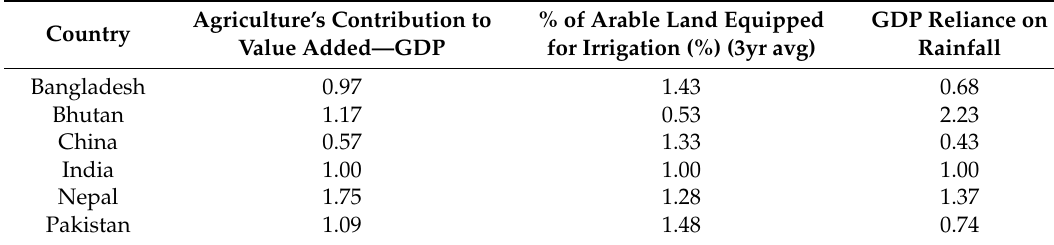
Table A2. National factors for reliance of GDP on rainfall for 2003 [24,25] calculated from the proportion of each country’s provided by the agricultural sector and the proportion of each country’s arable land with irrigation, all indexed to the respective values for India.